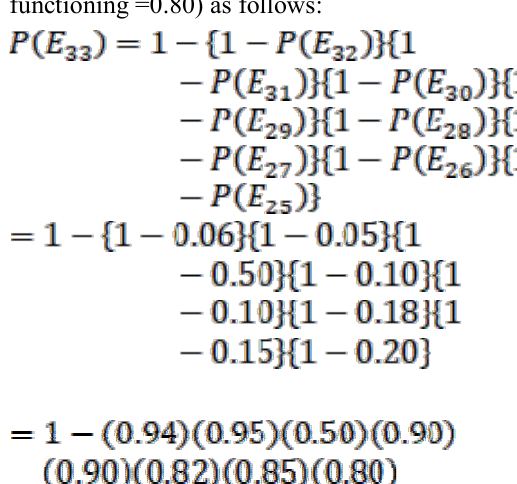
probability indicating the given error event and their occurrence with the calculated